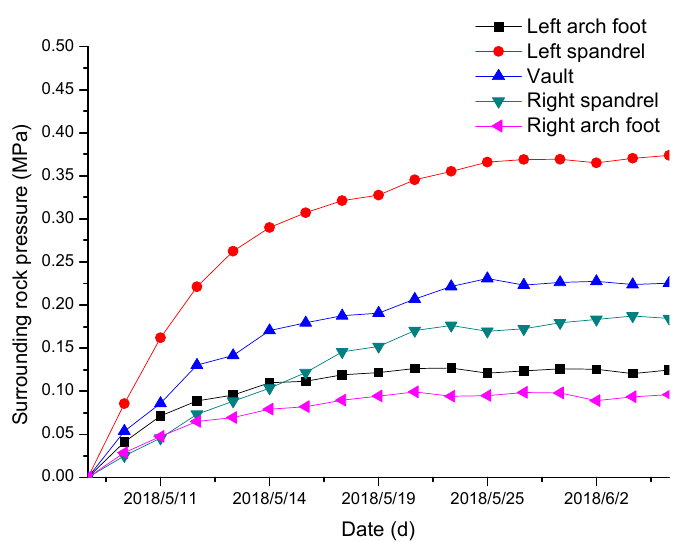
Figure 10. Time history curve of surrounding rock